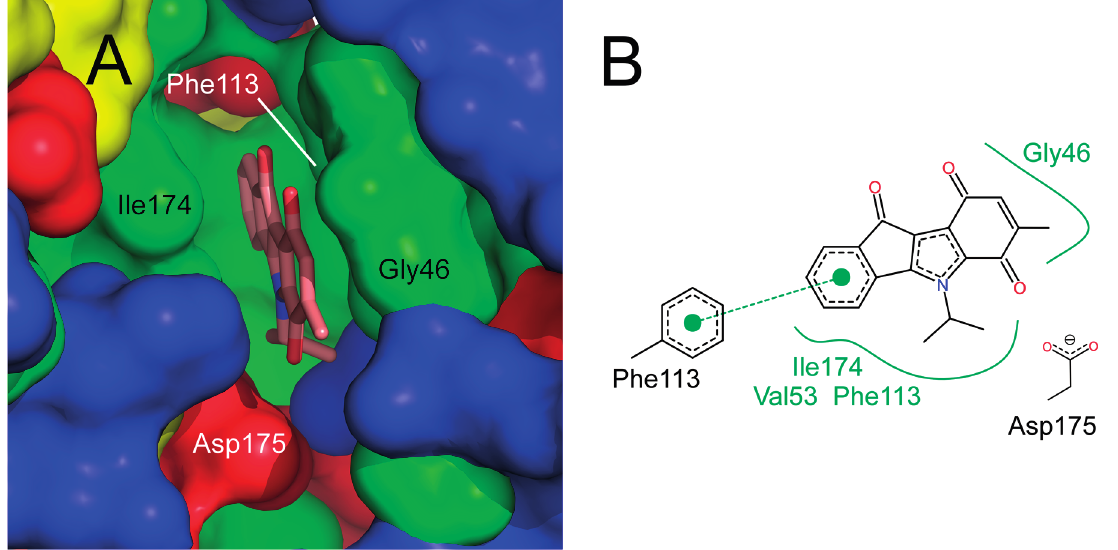
Figure 7. ( A ) Predicted binding mode of 7a in the binding pocket of CK2. Green: hydrophobic surface patches, yellow: hydrophilic surface patches, blue (red): positively (negatively) polarized surface patches. Val53 and Ile174 shown in panel B are hidden behind Gly46. ( B ) Schematic view of the interactions between 7a and neighboring amino acids (modified from a PoseView drawing